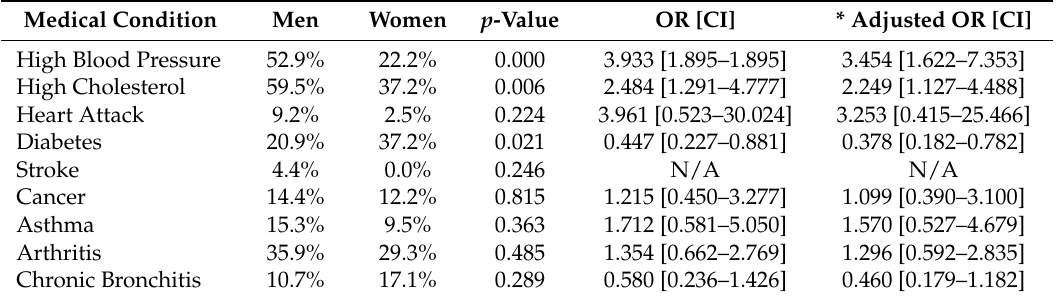
Table 5. Direct comparison of medical condition prevalence in men & women of the Ft. Devens